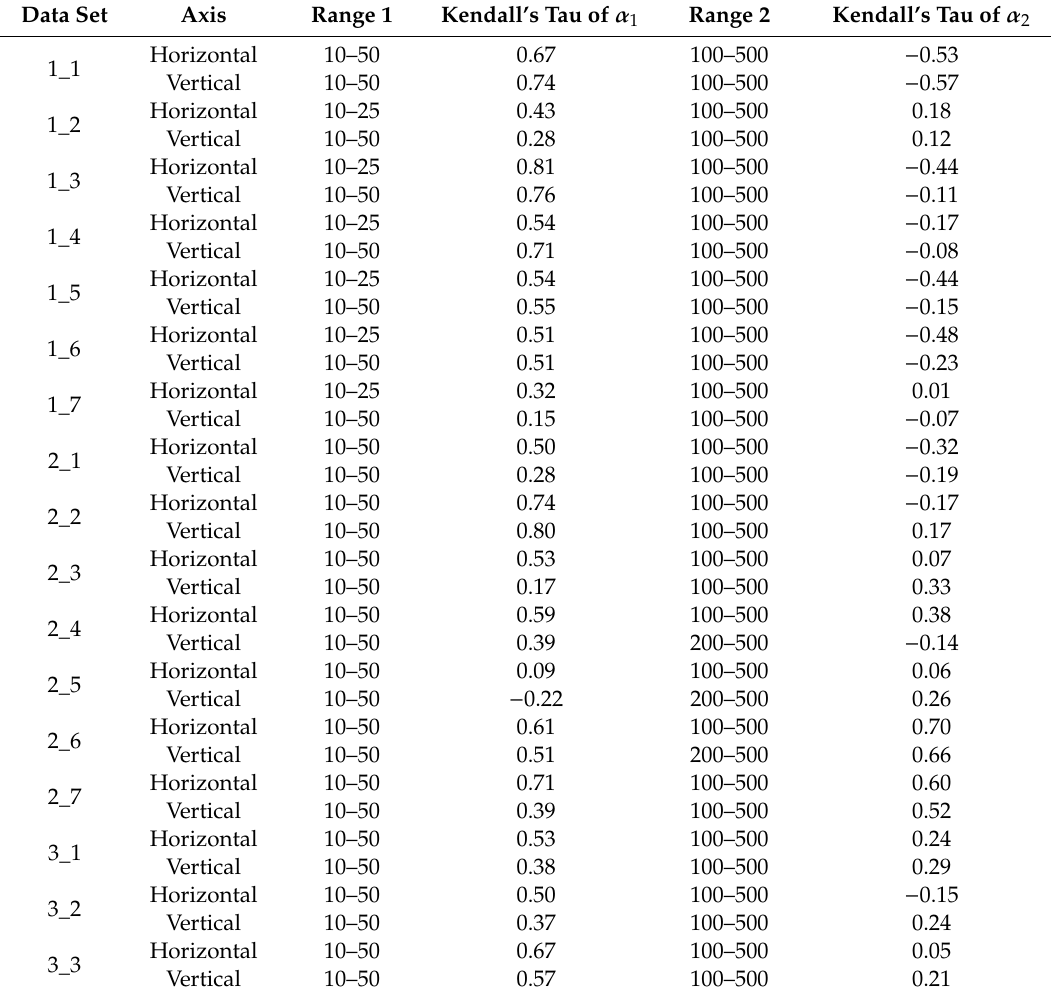
Table 4. Kendall’s tau of the scaling exponents ( α 1 and α 2 ) for several bearing vibration signals toward their